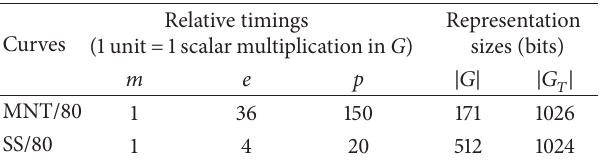
Table 3: Timings needed to perform atomic operations and repre- sentation of group elements in